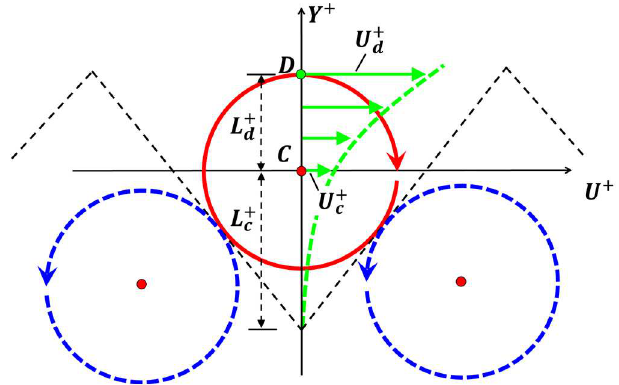
Figure 8. Assumption of migration flow.